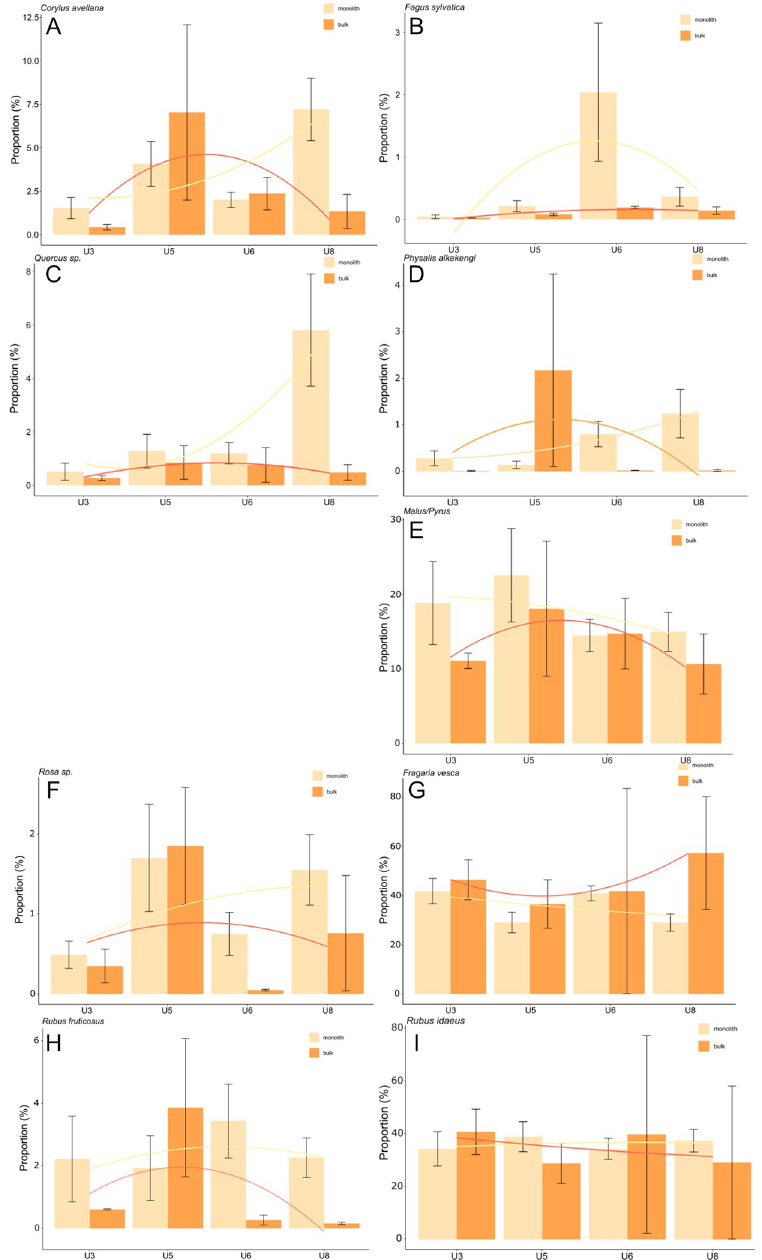
From a diachronic perspective, the results of emmer and naked wheat of units